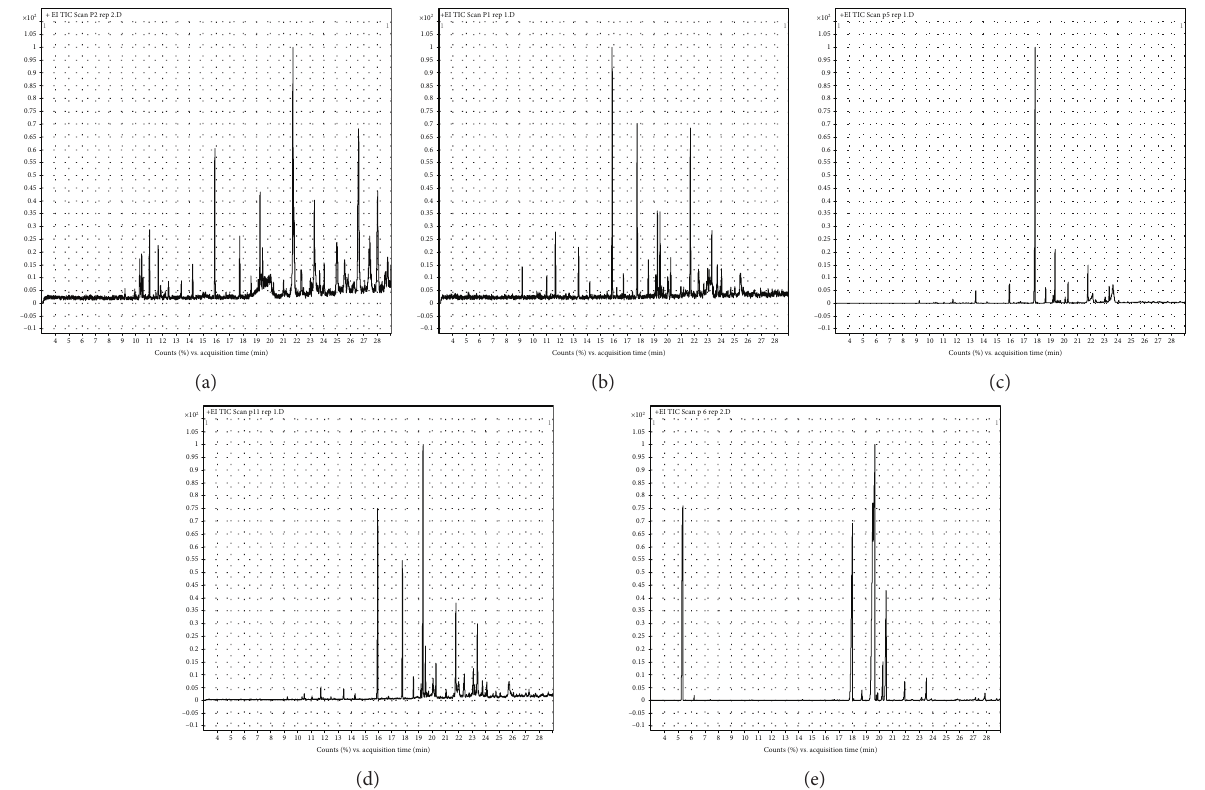
Figure 1: GC-FID chromatograms of the five chemotypes of Pinus nigra essential oils: (a) caryophyllene oxide, (b) camphene, (c) ß -caryophyllene, (d) α -amorphene, and (e) germacrene D.